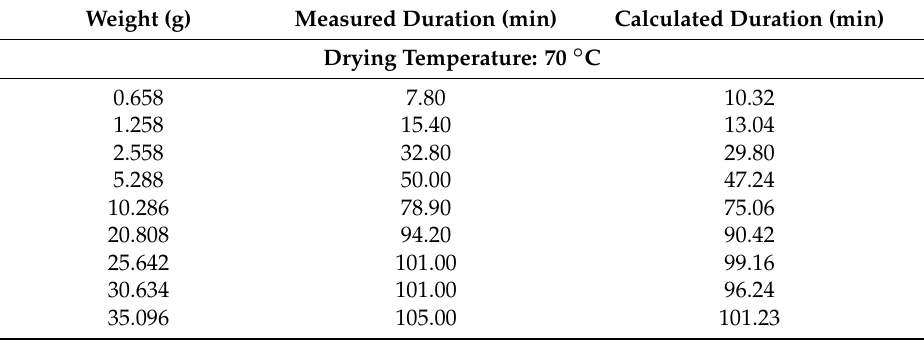
Figure 8. Drying time measured and those determined by the established mathematical model for different drying tests. Table 3. Drying times measured and those determined by the mathematical model established for different drying tests.